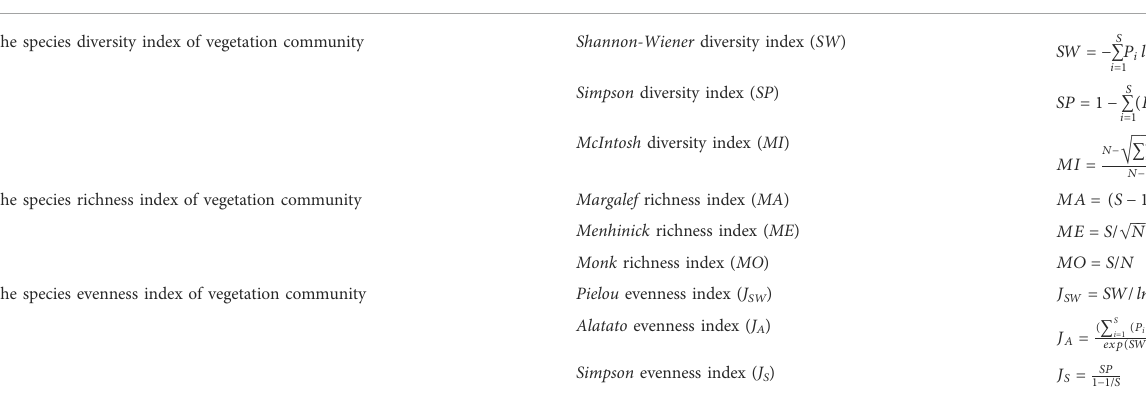
TABLE 2 Formula used to calculate vegetation community diversity